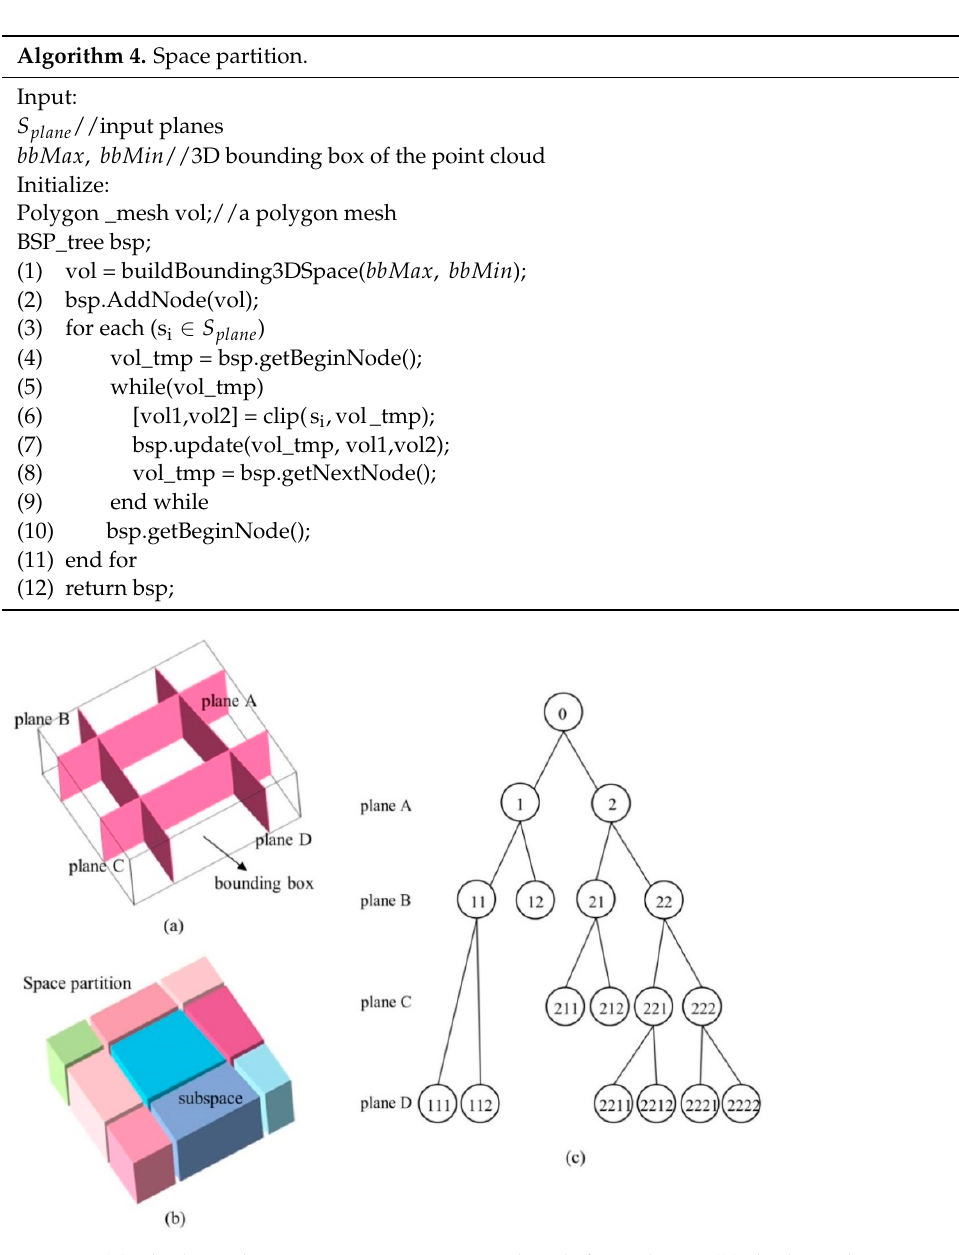
Figure 6. ( a ) The bounding 3D space is partitioned with four planes; ( b ) the bounding 3D space is divided into nine subspaces which correspond to the leaf node of BSP tree; ( c ) a plane divides the space into two half spaces and BSP tree is used to maintain the hierarchical relationship of the subdivided space.